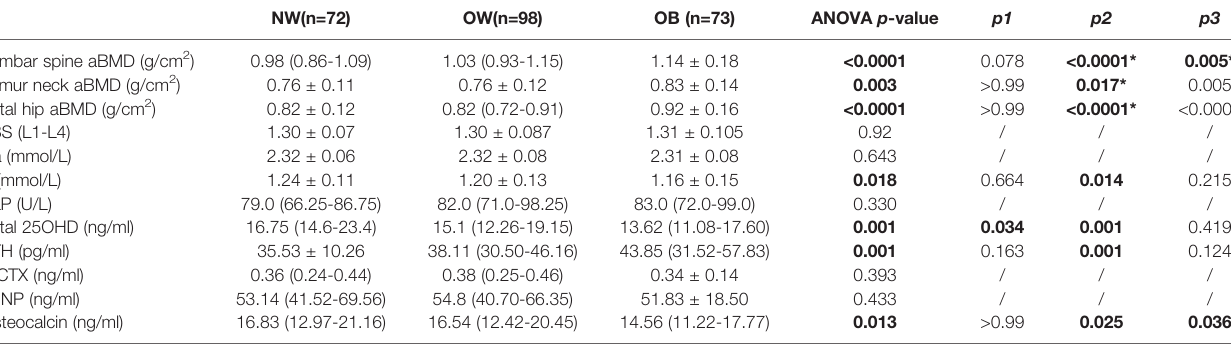
TABLE 2 | Age-adjusted measurements of aBMD and biochemical characteristics in normal-weight (NW), overweight (OW), and obese (OB) postmenopausal